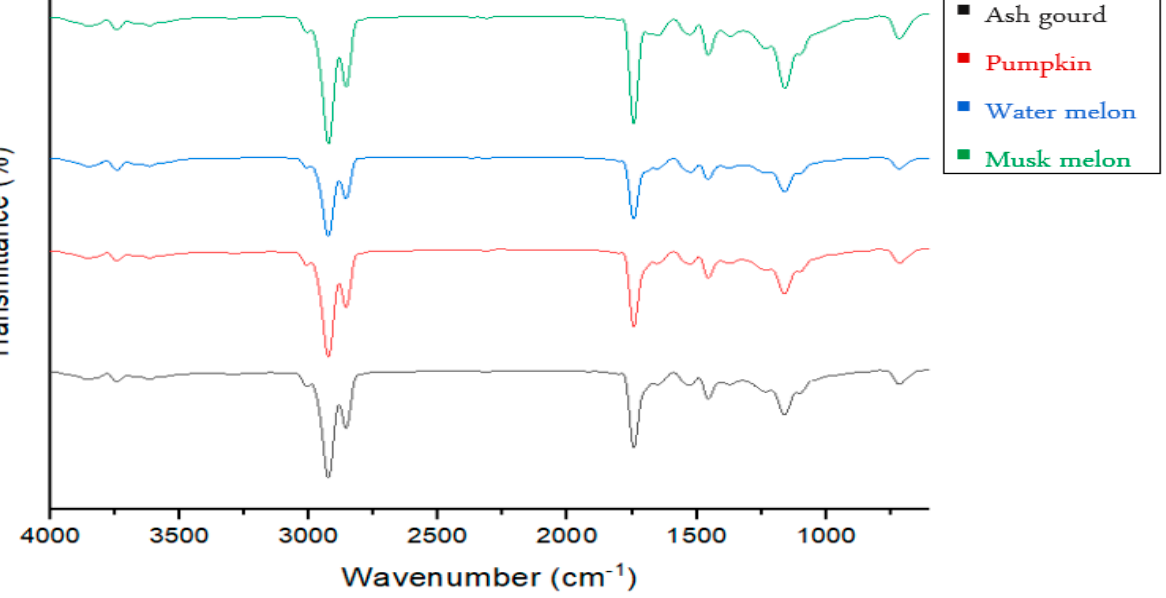
Table 6. Thermal transition behavior of seeds.